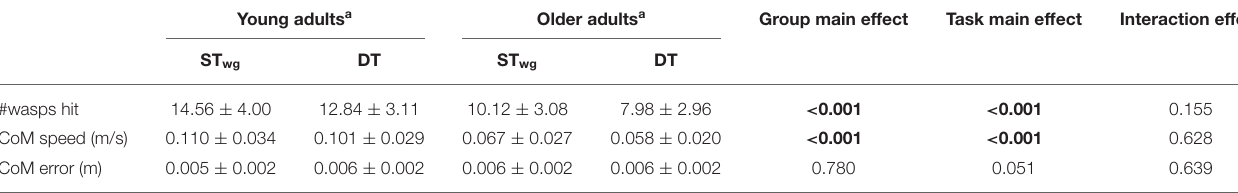
TABLE 2 | Weight-shifting outcomes for young and older adults during wasp game ST and DT.